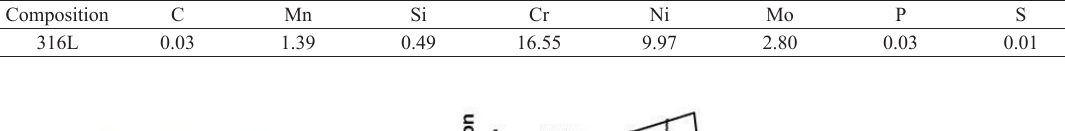
Table 1. Chemical composition of the 316L austenitic stainless steel (wt%). Composition